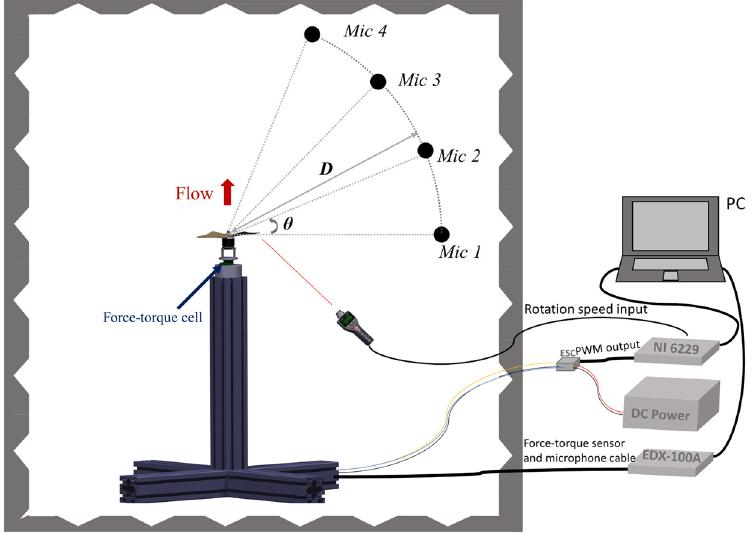
Figure 1. The hover stand setup in an anechoic chamber for aerodynamic and acoustic measure-